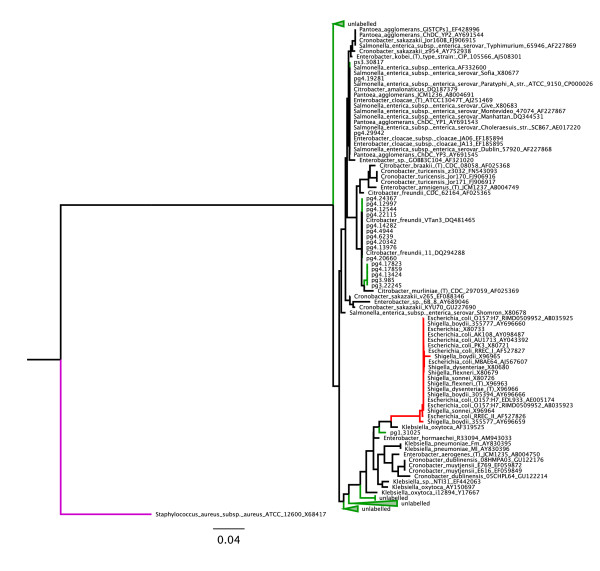
Neighbor-joining phylogenetic tree of reads mapping to members of the Enterobacteriaceae family. Screening our dataset for putative E. coli/Shigella/Salmonella species we discovered most hits were from the fruit surface samples. We found that by including 16S rRNA reference sequences from members of other related genera including Citrobacter and Cronobacter, we could not confidently assign any sequences from our dataset to Salmonella due to poor phylogenetic resolution. However, we did determine that no reads mapping to the Enterobacteriaceae family were from E. coli/Shigella. The E. coli/Shigella monophyletic clade is colored in red, the Staphylococcus aureus outgroup is purple, and monophyletic clades of sequences from our dataset are colored in green.